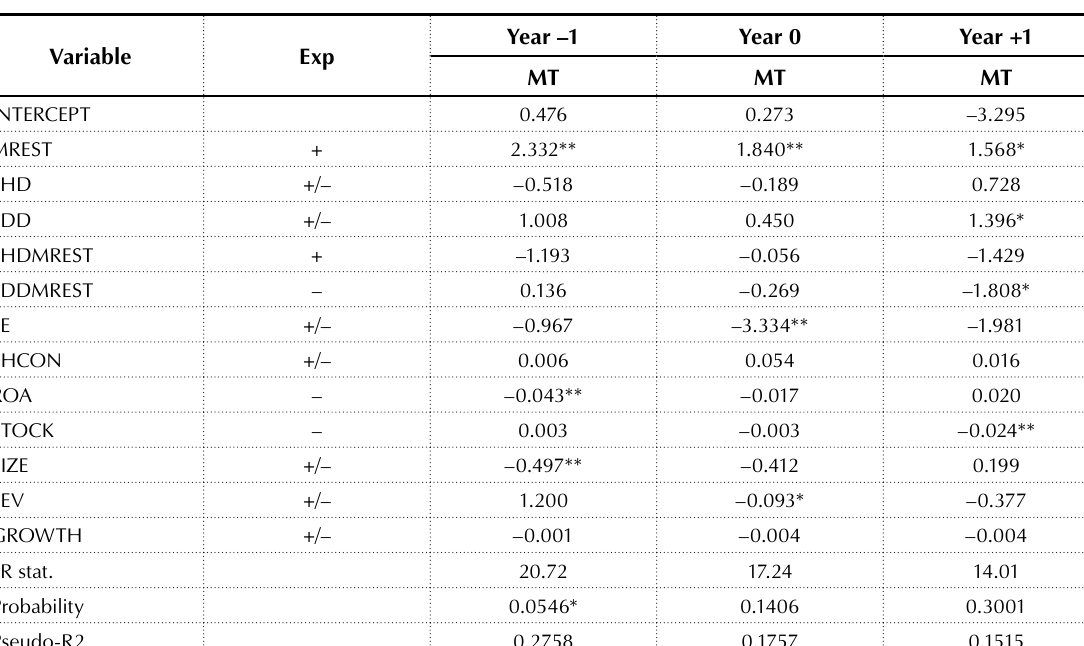
Table 2. Management turnover in a given year – logistic